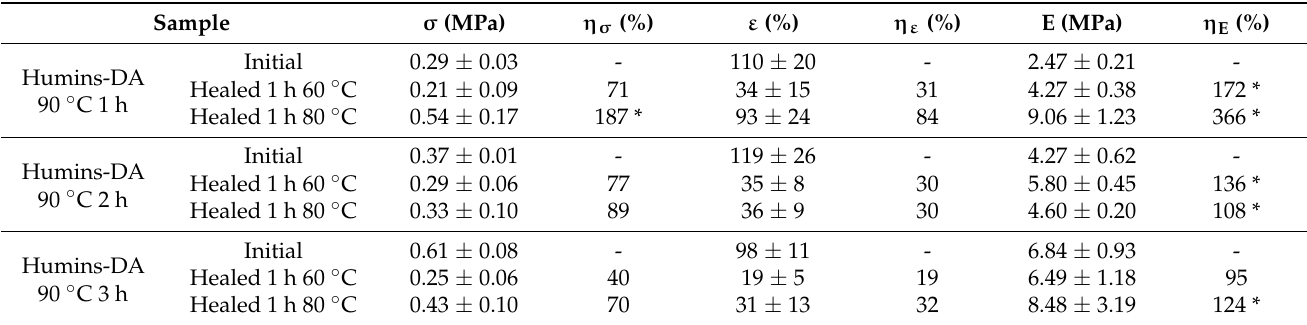
Table 3. DMA parameters obtained for the annealed Humins-DA, together with the respective healing efficiencies at both 60 ◦ C and 80 ◦ C for 1